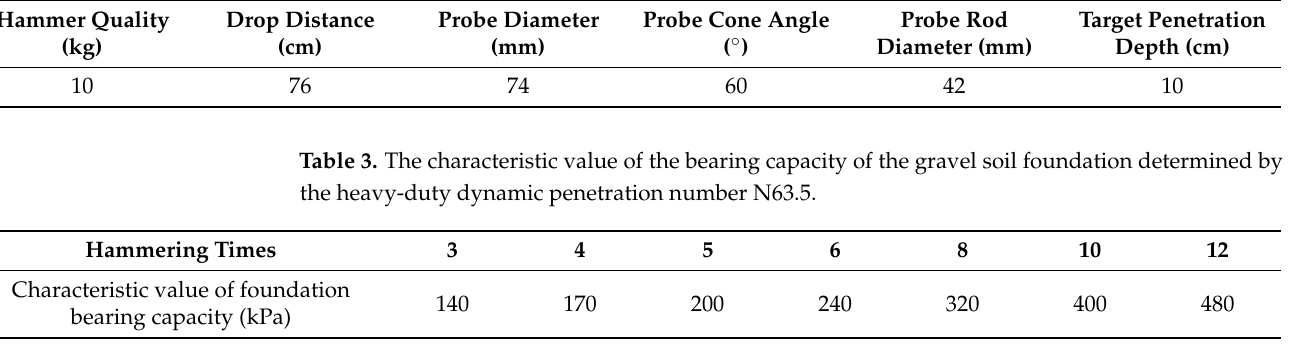
Table 2. Heavy-duty dynamic penetration parameters.